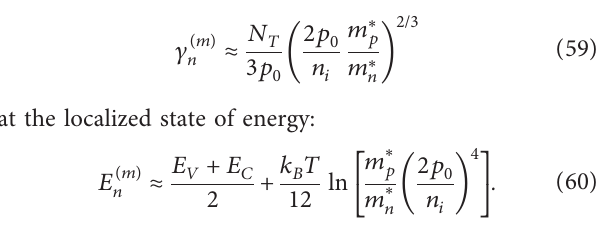
Figure 2. The blue and the red curves in Figure 3 represent the lifetimes corresponding to the excess electrons and holes, respectively. Since τ p sitely with the variation of the localized state energies, they are drawn for the reference in Figures 3(a)–3(c). The plots under the curves in Figures 3(a) and 3(c) can be divided into five distinct regions labelled I, II, III, IV, and V, while the plot under Figure 3(c) can be divided into three regions labelled I, II, and III. As one can see from Figures (a) and (b), the values of τ